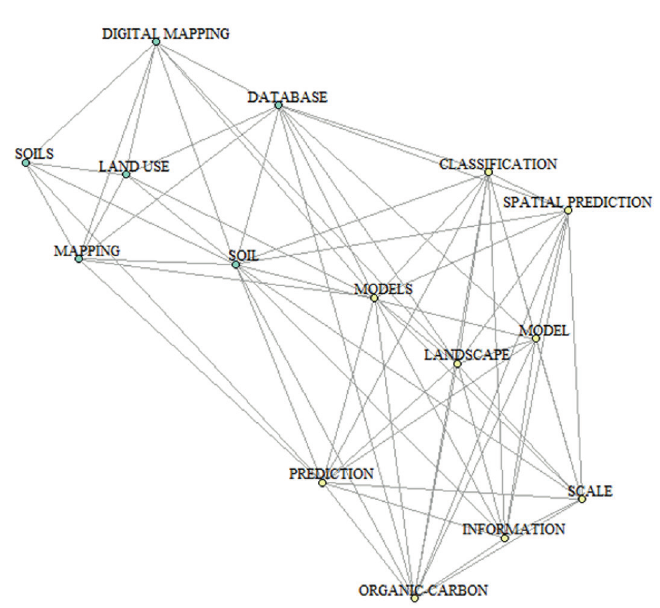
Figure 2 - The 15 keywords with highest frequency in DSM